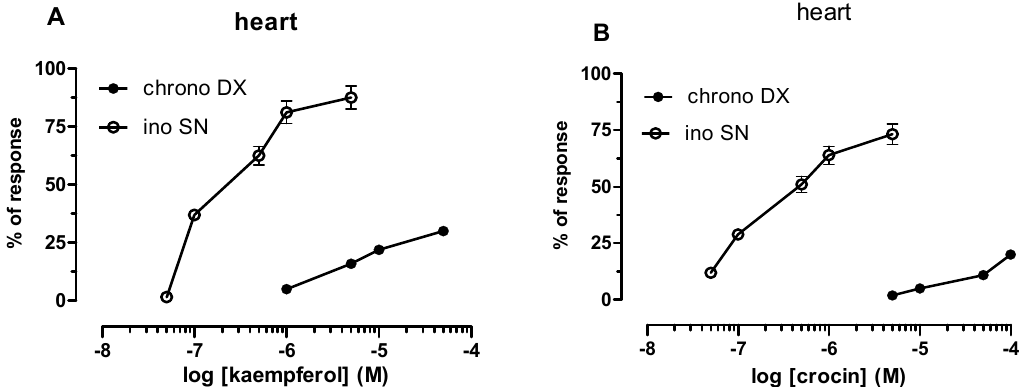
Figure 3. Negative inotropic and chronotropic effects on guinea pig left (ino SN) and right atrium (chrono DX) respectively. Cumulative concentration–response curves for kaempferol ( A ) and crocin ( B ) were obtained using negative effects as percentage of the initial tension (left atria) and initial rate (right atria). Each point is the mean ± SEM of four–six experiments ( n = 4–6). Where error bars are not shown these are covered by the point itself.